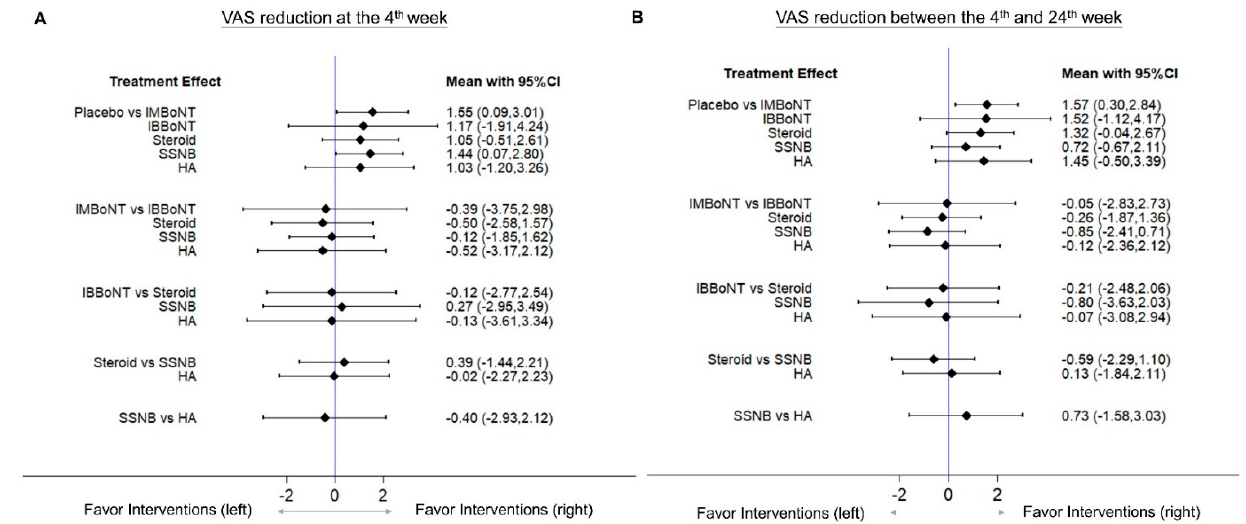
Figure 4. Forest plots of the network estimates derived from all the direct and indirect pairwise comparisons of the treatment effects in terms of VAS reduction ( A ) at the 4th week and ( B ) between the 4th and 24th weeks after interventions. BoNT, botulinum toxin; HA, hyaluronic acid; IB, intra-bursal; IM, intra-muscular; SSNB, suprascapular nerve block; VAS, visual analogue scale.